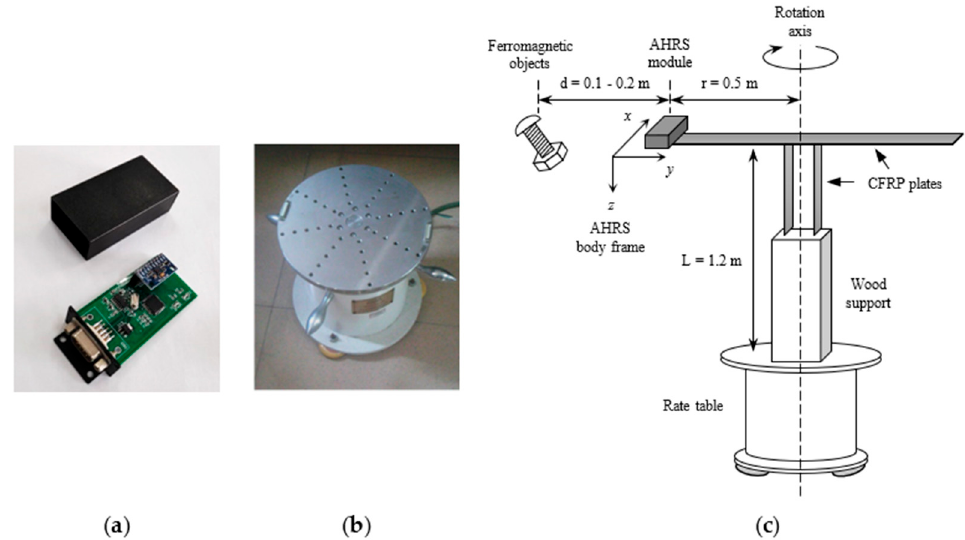
Figure 3. Experimental apparatus. ( a ) AHRS module. ( b ) Single-axis rate table. ( c ) Hardware installation (not to scale).